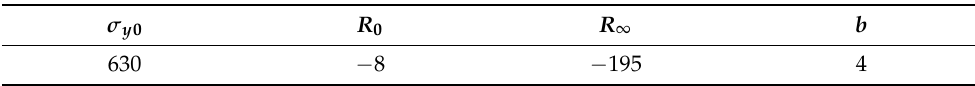
Figure 17. Results of sensitivity analysis for parameter μ .